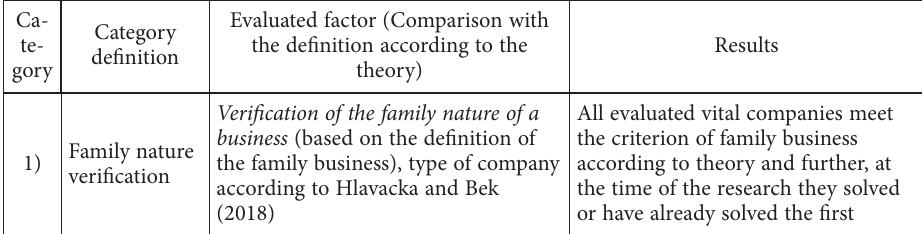
Table 4. Evaluation of family businesses using research case studies – by category Ca-